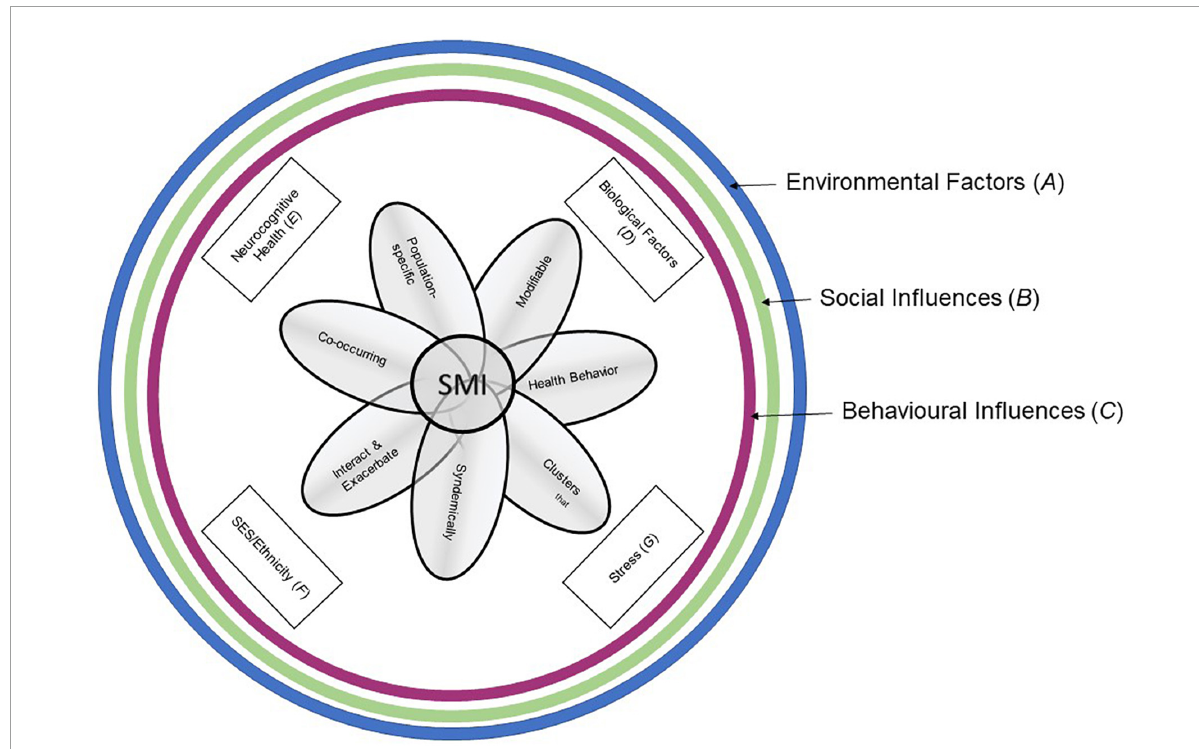
FIGURE1 Syndemic Framework to SMI Development and Maintenance. The figure shows the inward trajectory of how influential layers of habits and modifiable behaviors can contribute to the course of an SMI in individuals. Broader environmental factors influence social factors, which in turn influence common behaviors. The more individual contributors of biological factors, neurocognitive health, SES/Ethnicity status, and stressors, influenced also by the greater factors encircling them, lead to a more nuanced and person-specific picture of SMI development and maintenance, and in turn influence specific modifiable behaviors with a direct impact on an individual’s